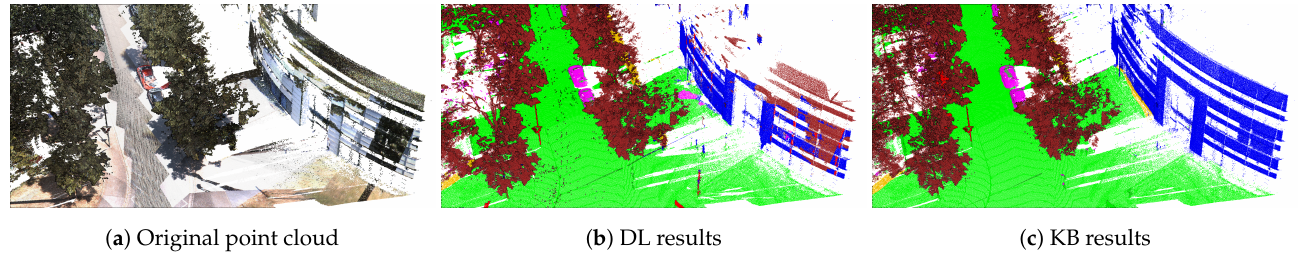
Figure 9. Sample semantic segmentation results